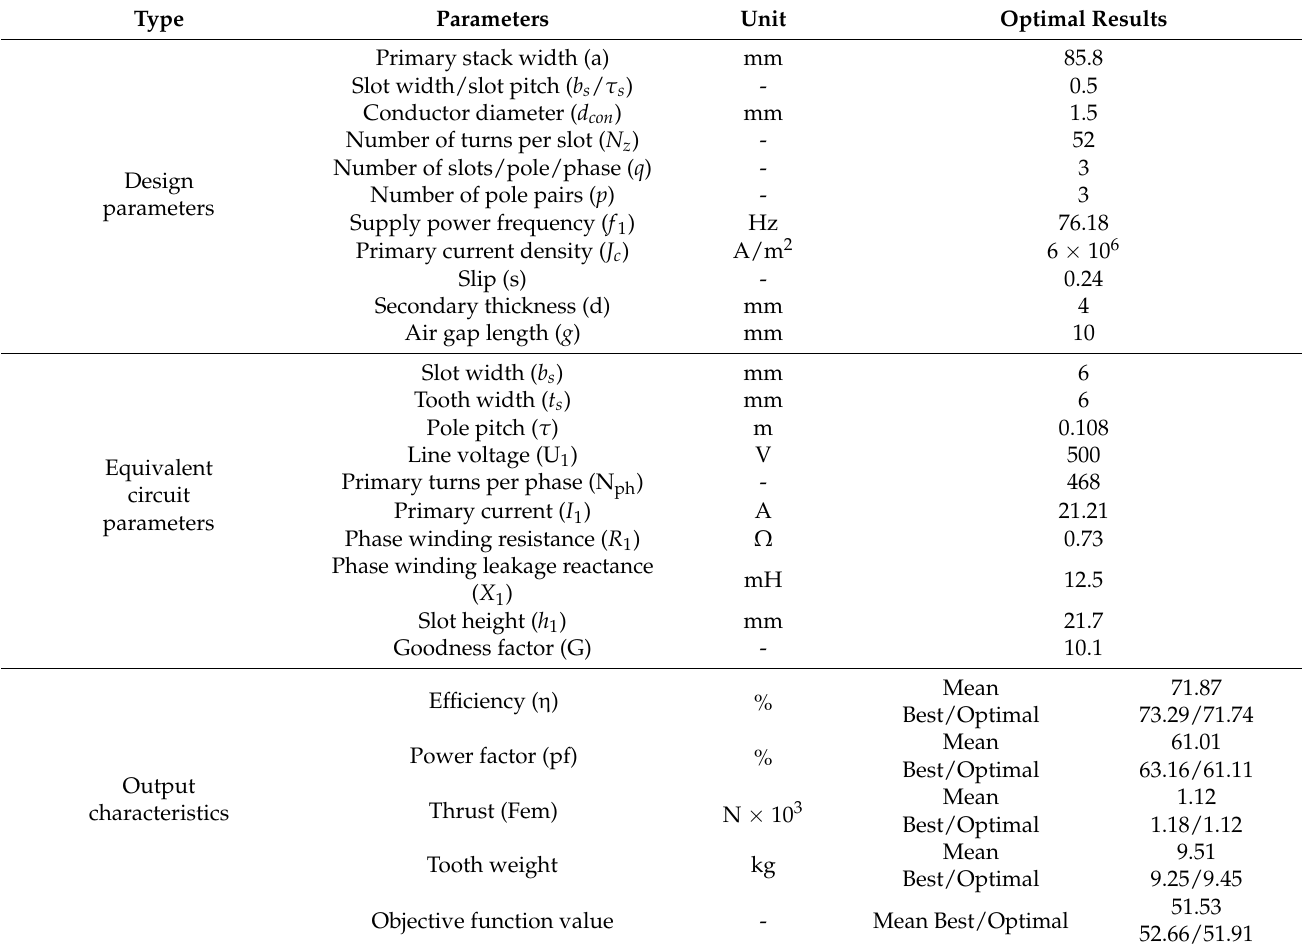
Table 3. Optimal design results of SP-DLIM by DE within 51 independent